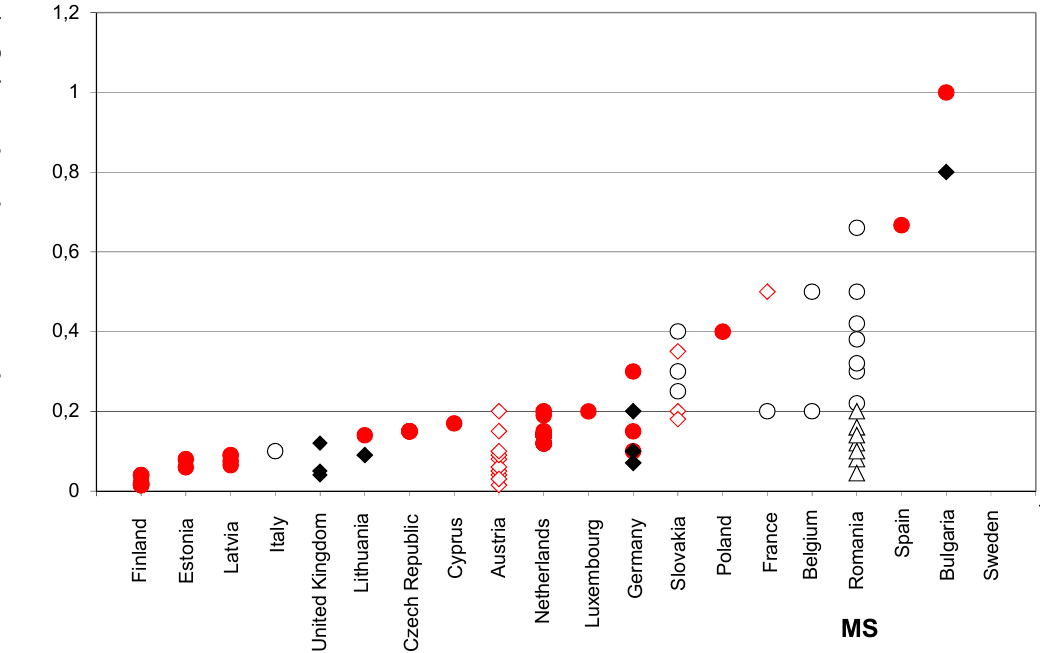
Figure 2. Total phosphorus or orthophosphate values for good-moderate boundaries of ecological status in European streams and rivers. Filled circles = Total phosphorus as annual mean values or mean values for defined seasons or no entry. Open circles = Total phosphorus as 90 percentile values of annual measurements. Triangles = Total phosphorus median values. Filled diamonds = Orthophosphate/soluble reactive phosphorus as annual mean values. Open diamonds = Orthophosphate as 90 percentile values of annual measurements. Values provided by CZ, FR, BG, PL, LT, LU, CYP and IT are good-moderate boundaries set for “All rivers” (without typological differences).